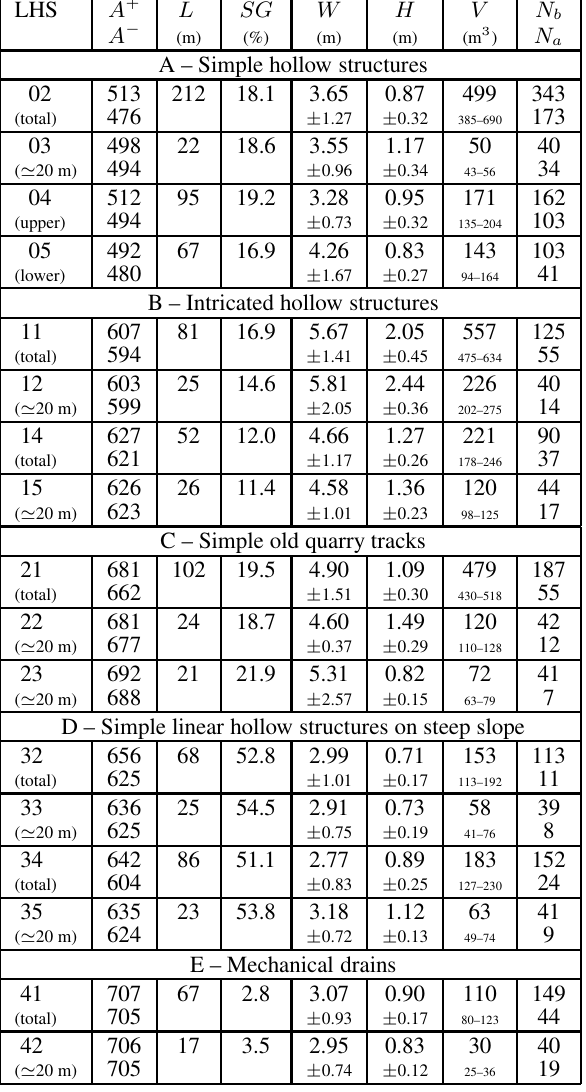
Table 1. Linear hollow structures measures. A : altitude, L : 3D length, SG : slope gradient, W : mean width, H : mean depth, V : volume, N b : number of selected bumps, number of accepted bumps.